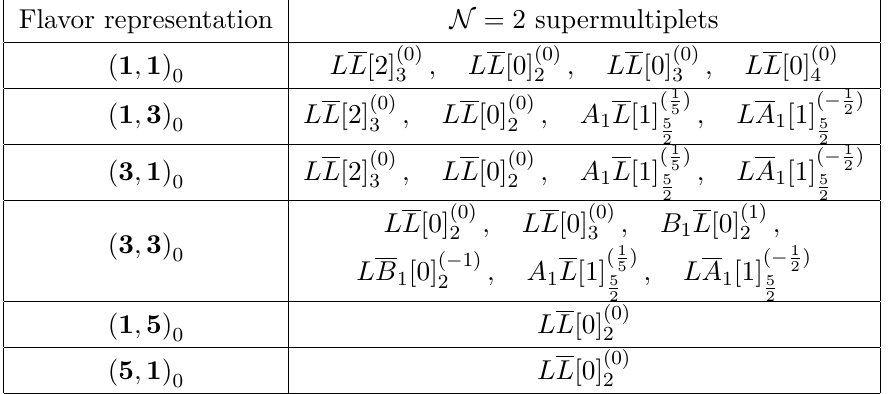
Table 16 . The N = 2 multiplets from the KK spectrum at level n = 2 for the antiperiodic spin structure. The SU(2) 1 × SU(2) 2 × U(1) flavor symmetry representations are indicated in the SU(4) left